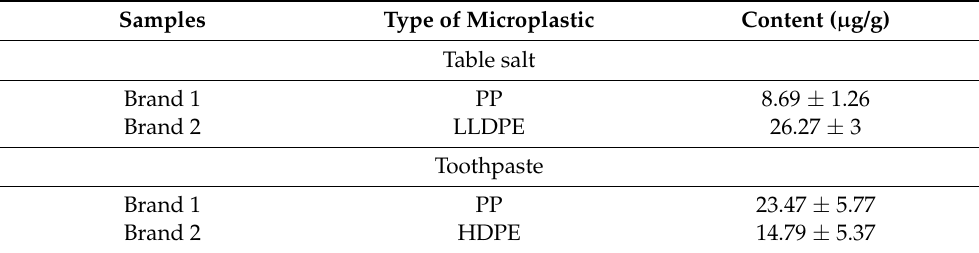
Table 3. Microplastic content in table salt and toothpaste.